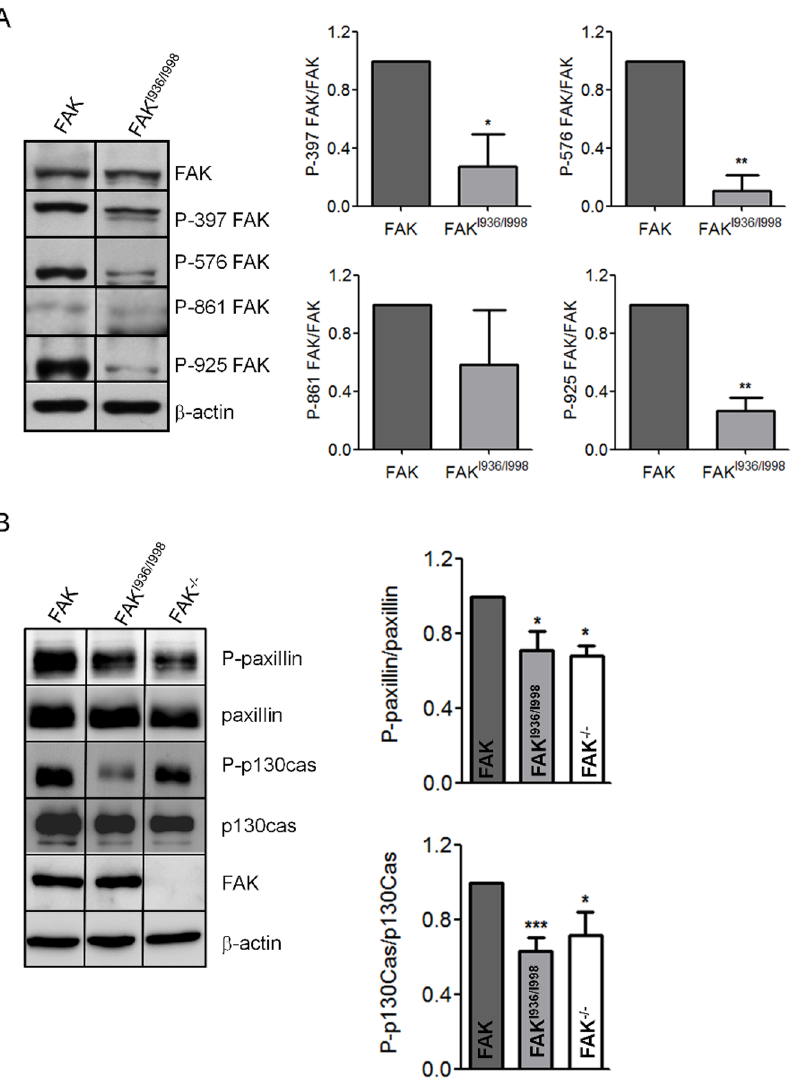
Figure 2. Phosphorylation status of FAK and FAK substrates in FAK -/- cells re-expressing wild-type FAK and FAK I936/I998 . (A) Graphs show decreased FAK phosphorylation at Tyr 397 , Tyr 576 and Tyr 925 in FAK I936/I998 cells compared to wild-type FAK cells (*p , 0.013, **p , 0.0002; n=4 to 6 independent experiments). (B)RepresentativeWestern blots showing thephosphorylation states of paxillin andp130Cas inFAK -/- , FAKandFAK I936/I998 - expressing cells. Graphs show decreased phosphorylation of paxillin in both FAK I936/I998 cells and FAK -/- cells (*p , 0.03) compared to wild-type FAK cells (P=0.0097, F=6.165) and decrease phosphorylation of p130CAS in FAK I936/I998 cells (***p , 0.001) and FAK -/- cells (*p , 0.05) compared to wild-type FAK cells (p=0.0004, F=12.68; n=3 to 8 independent experiments).